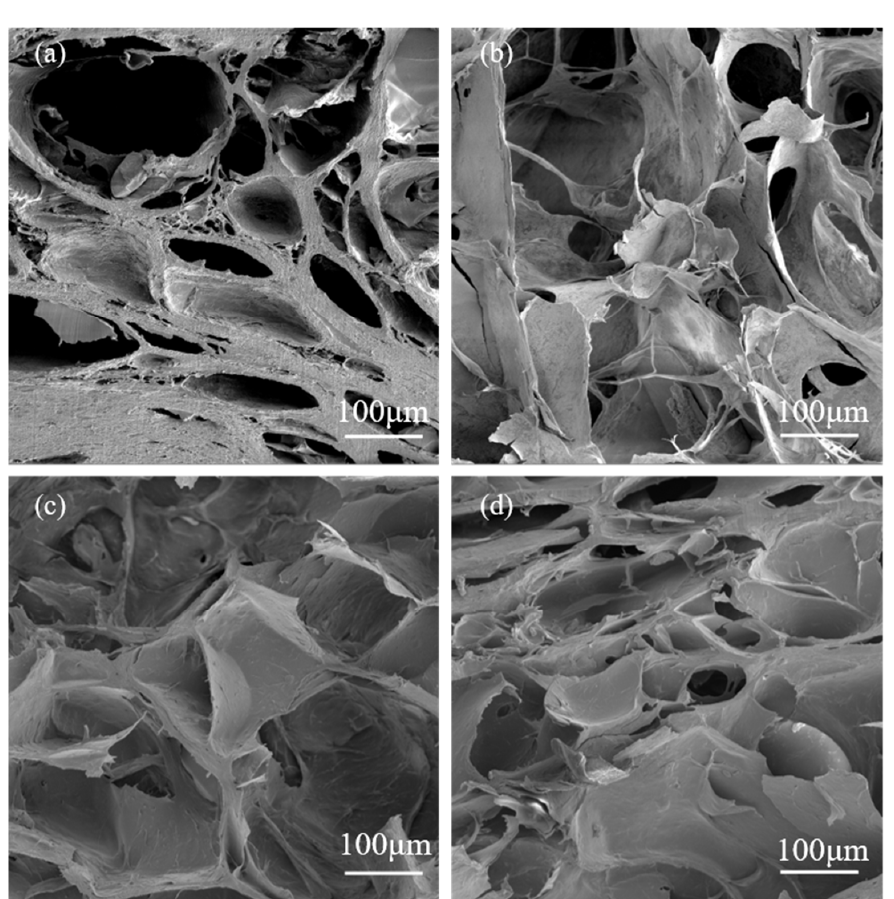
Figure 7. Cross-sectional SEM images of hydrogel after swelling in a solution at pH 1.2 ( a , c ) and pH 7.4 ( b , d ).